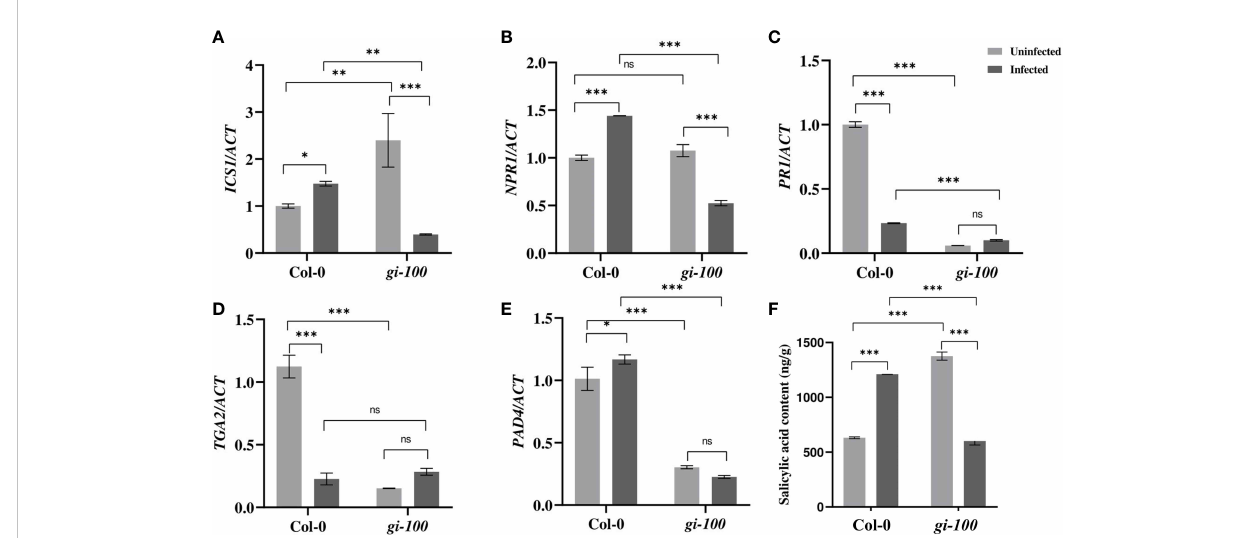
FIGURE 4 Involvement of the salicylic acid pathway during F. oxysporum infection in gi-100 plant infection. (A – E) Transcript expression validation using RT- qPCR and (F) quantitative pro fi ling of salicylic acid amount at 24 DPI by F. oxysporum were done in gi-100 and Col-0 lines of A thaliana. (A) ISOCHORISMATE SYNTHASE 1 ( ICS1 ), (B) NON-EXPRESSOR OF PATHOGENESIS-RELATED GENES 1 ( NPR1 ), (C) PATHOGEN RESPONSIVE GENE 1 ( PR1 ), (D) TGACG SEQUENCE-SPECIFIC BINDING PROTEIN 2 ( TGA2 ), and (E) PAD4 . ACTIN were used to normalize transcript levels. Determination of (F) salicylic acid (SA) amount. For SA quanti fi cation, D4-salicylic acid was taken as standard. Values are presented as mean ± SE. The qRT-PCR reactions were done in triplicate from three biological replicates. Two-way analysis of variance (ANOVA) using Sidak ’ s multiple comparisons test was performed with the help of GraphPad Prism to test for signi fi cance among the dataset, * p < 0.05. ** p < 0.01, *** p < 0.001. ns, Non-signi fi